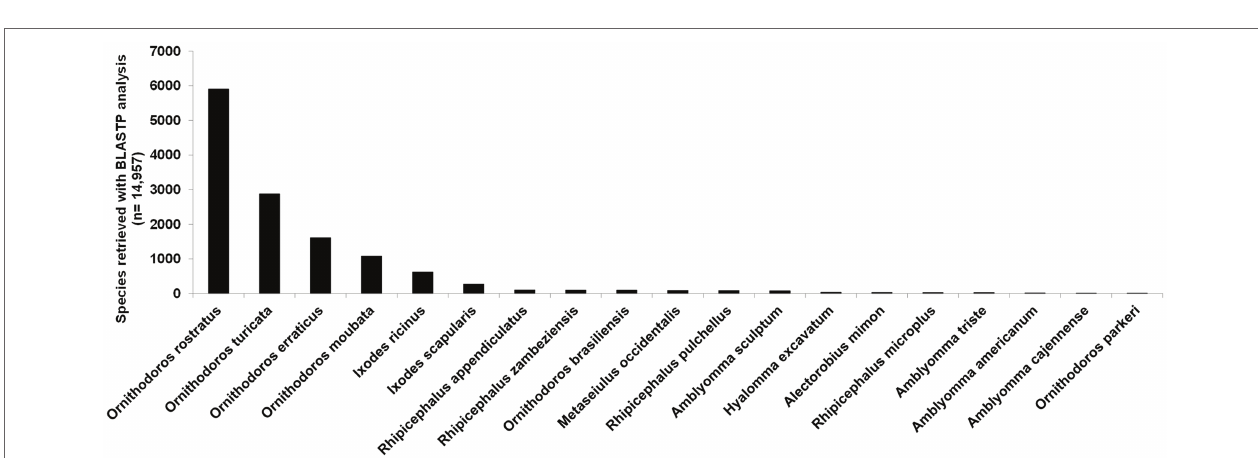
FIGURE 1 | the vertical axis. Transcriptomes used in the comparison are as: H. dromedarii (Bensaoud et al., 2018), R. annulatus (Antunes et al., 2019), R. appendiculatus (de Castro et al., 2016), O. rostratus (Araujo et al., 2019), I. holocyclus (Rodriguez-Valle et al., 2018), O. turicata (Bourret et al., 2019), R. zambeziensis (de Castro et al., 2017), H. excavatum (Ribeiro et al., 2017), I. ricinus (Schwarz et al., 2013, 2014), A. triste (Garcia et al., 2014), R. pulchellus (Tan et al., 2015), A. sculptum (Moreira et al., 2017), A. maculatum (Karim et al., 2011), A. sculptum (Esteves et al., 2017), A. cajennense (Garcia et al., 2014), and A. americanum (Karim and Ribeiro, 2015). (B) Comparison of protein sequence length in amino acid residues presented up to 2,000 residues against the number of proteins. Proteins were binned in windows of 20 based on protein length. (C) Reciprocal best hit analysis of the transcriptome of O. brasiliensis ( n = 14,957) against two closely related Neotropic and Nearctic tick species. Indicated are orthologs shared uniquely between species pairs or shared between all three species.